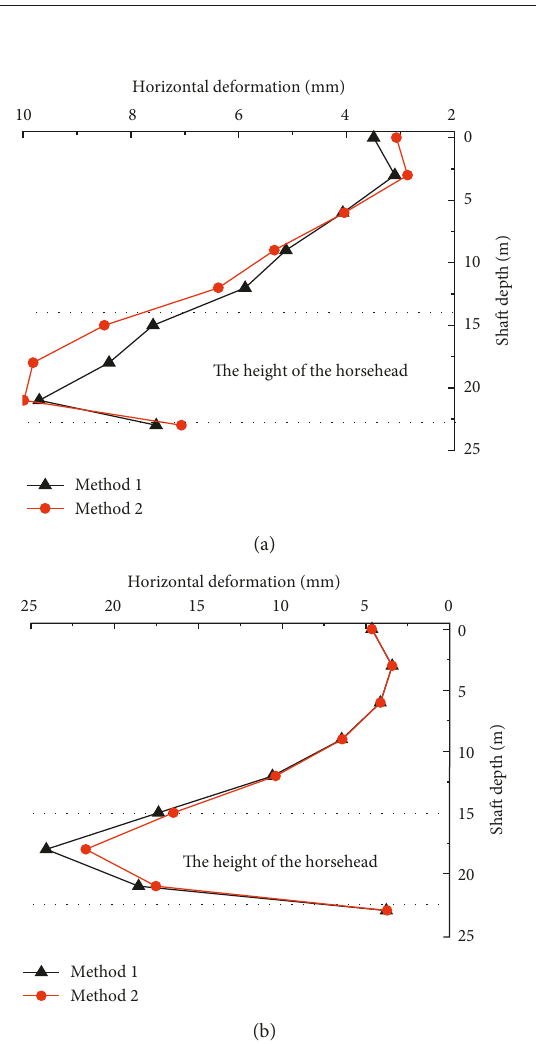
Figure 8: Deformation of shaft at different depths. (a) De- formations away from the horsehead. (b) Deformations parallel to the cross passage axis.